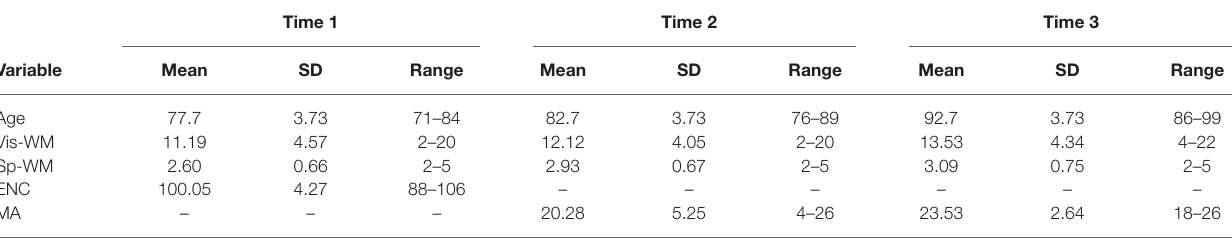
TABLE 1 | Descriptive statistics of the variables considered in the study for each time ( n = 43). Time 1 Time 2 Variable